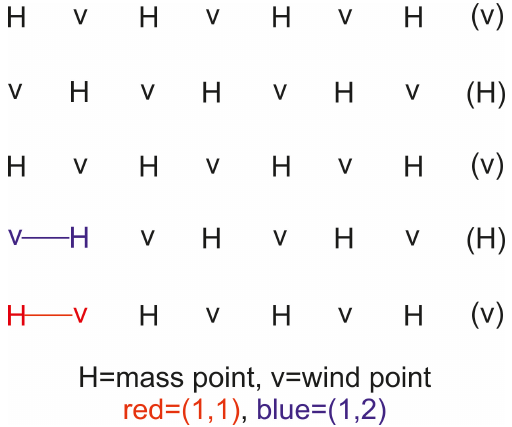
Figure 1. The E-grid stagger. The mass points represent by H and the wind points represent by v